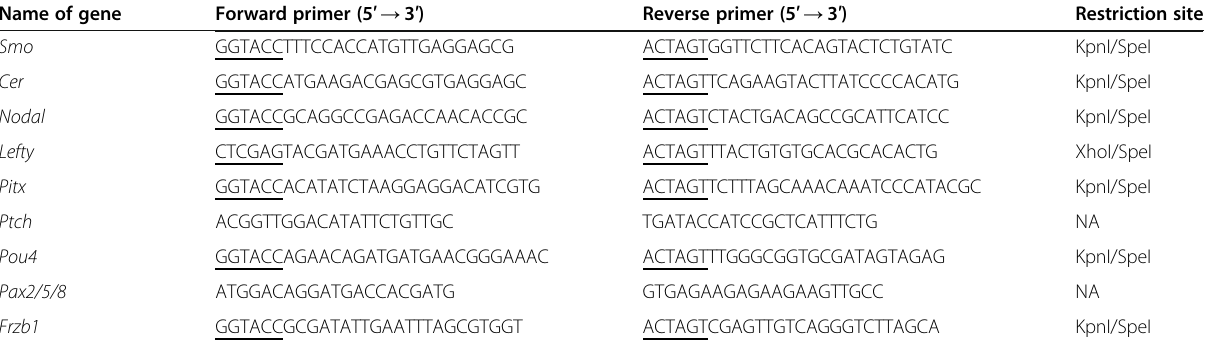
Table 1 List of primers used in this study Name of